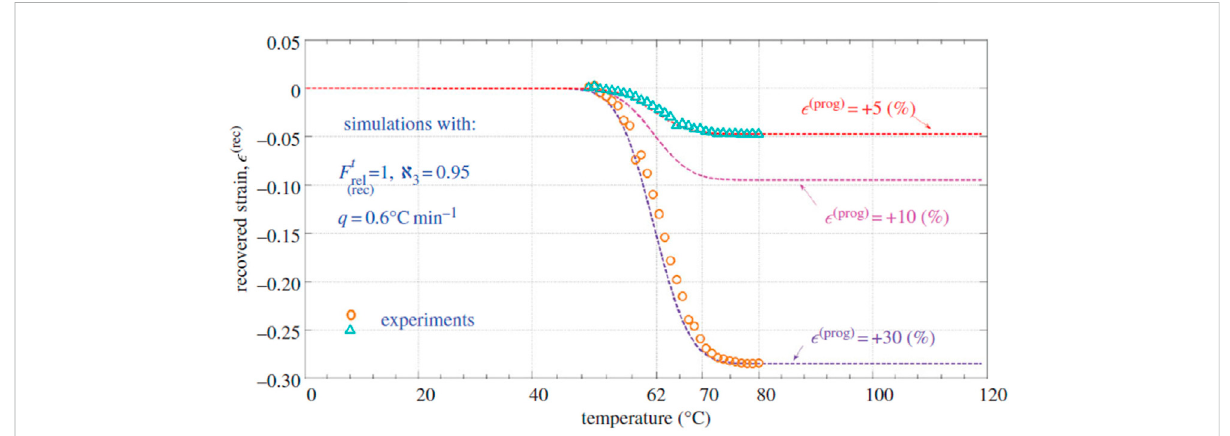
FIGURE 16 Comparison of experimental and simulation results for the effect of pre-strain levels on the fi nal shape recovery process (Shojaei and Li, 2014). [Reproduced with permission from Proceedings of the Royal Society A, 470: 20140199., (2014). Copyright 2014 Royal Society].